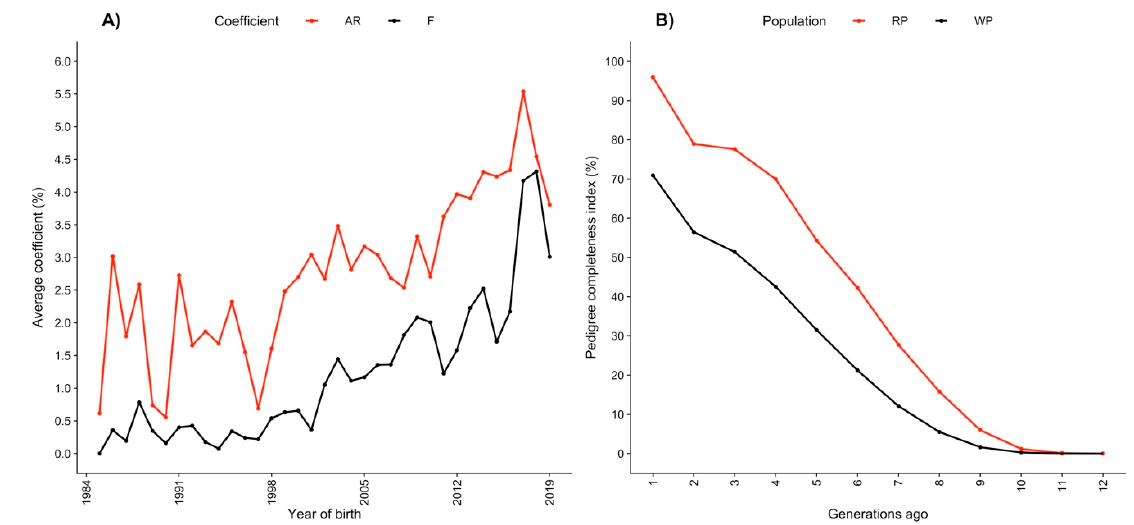
Figure 1. ( A ) Evolution of the average pedigree-based inbreeding ( F PED ) and relatedness ( AR ) coefficients from 1984 to 2019; ( B ) pedigree completeness index in the whole (WP) and reference (RF) populations.